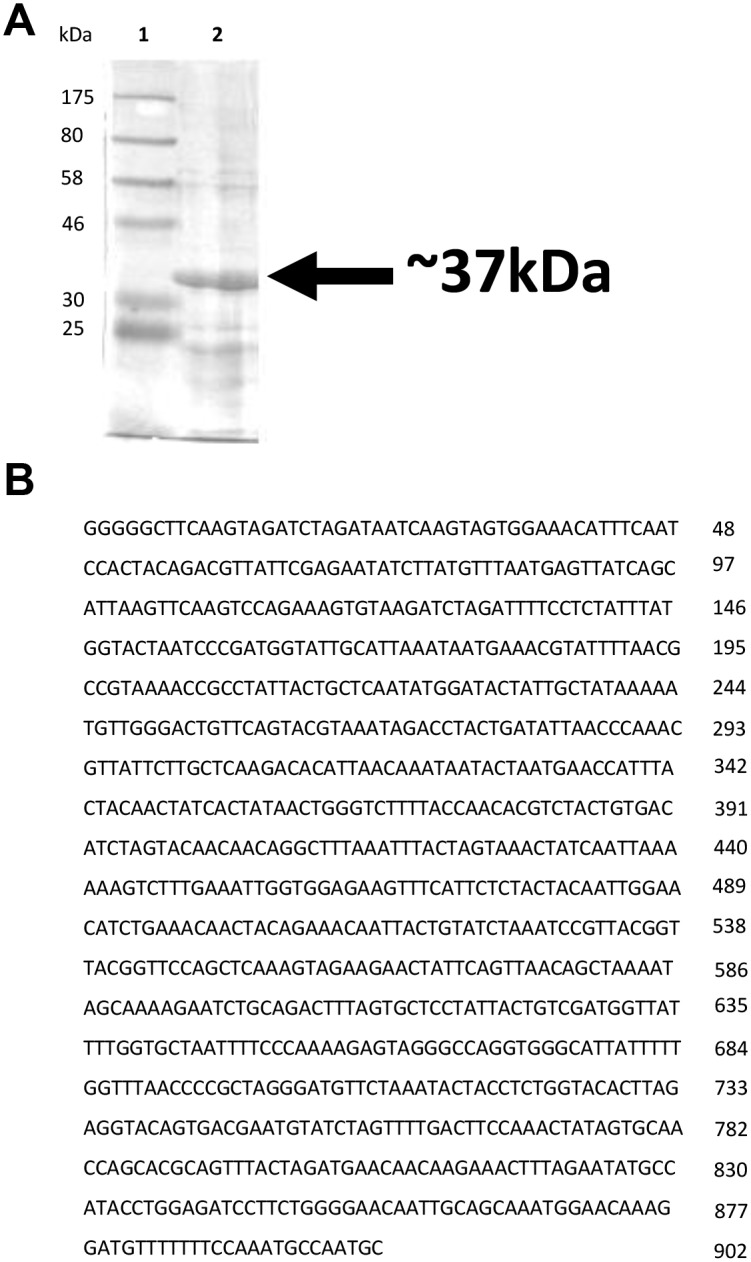
SDS-PAGE analysis of the 37kDa crystal protein of Bacillus thuringiensis 4R2 after Coomassie blue staining.(A) Lane 1: Molecular weight marker; lane 2: solubilized pro-PS2Aa1. (B) Nucleotides sequence of the cry46Aa1 gene fragment obtained following amplification with the Bt4R2-2F and Bt4R2-1R primer pair.